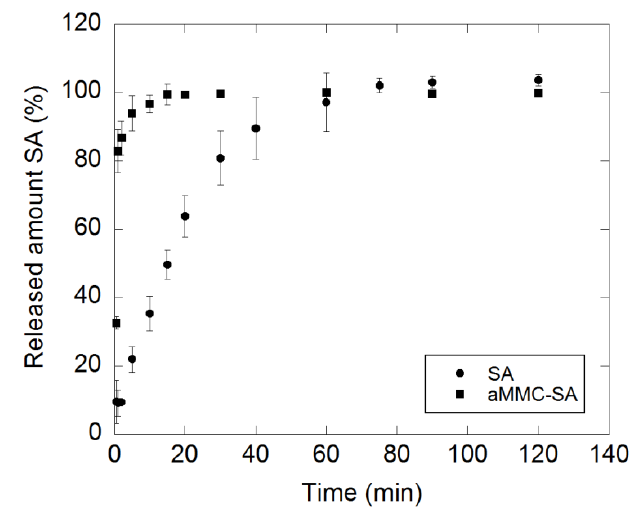
Figure 9. Dissolution profile of crystalline SA as well as release and concomitant dissolution profile of SA incorporated in aMMC. All measurements were made in triplicates and the data is displayed as the mean values with corresponding standard deviation.